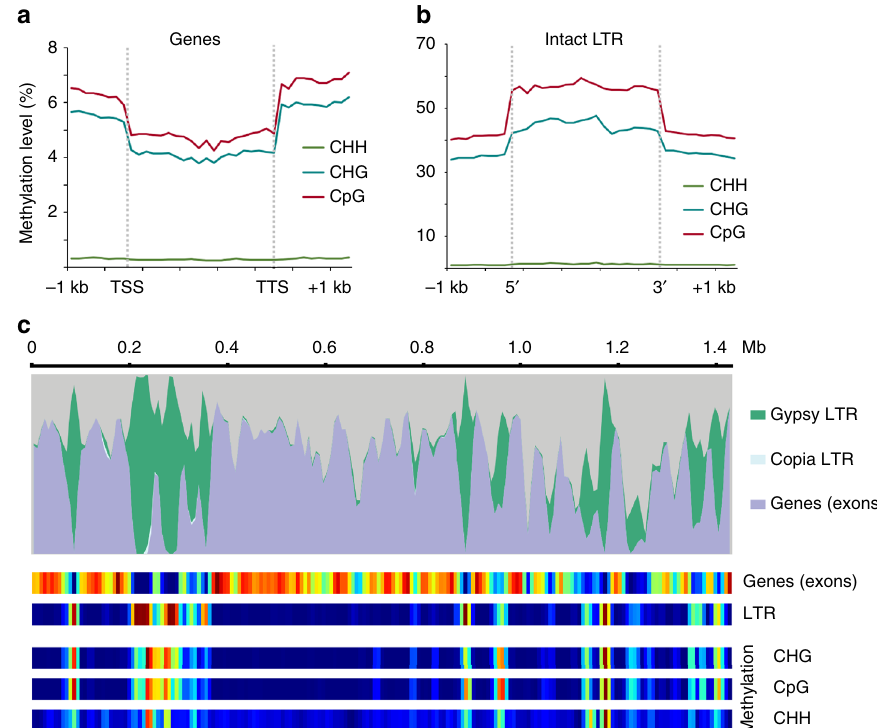
Fig. 3 Global methylation patterns in the S. lepidophylla genome. a S. lepidophylla lacks gene body methylation. Levels of CHH (green), CHG (blue) and CpG (red) methylation are plotted in the upstream (transcriptional start site; TSS), downstream (transcriptional termination site (TTS), and body of genes. b Intact LTR retrotransposons are highly methylated with decreasing levels at the 5 ′ - and 3 ′ - fl anking regions. c Methylation levels are highly variable across the genome with strong correlation of LTR retrotransposon density. Top, genome landscape of genomic features across Contig 1. Bottom, heatmap of genomic features and methylation levels, where blue indicates low abundance and red signi fi es high